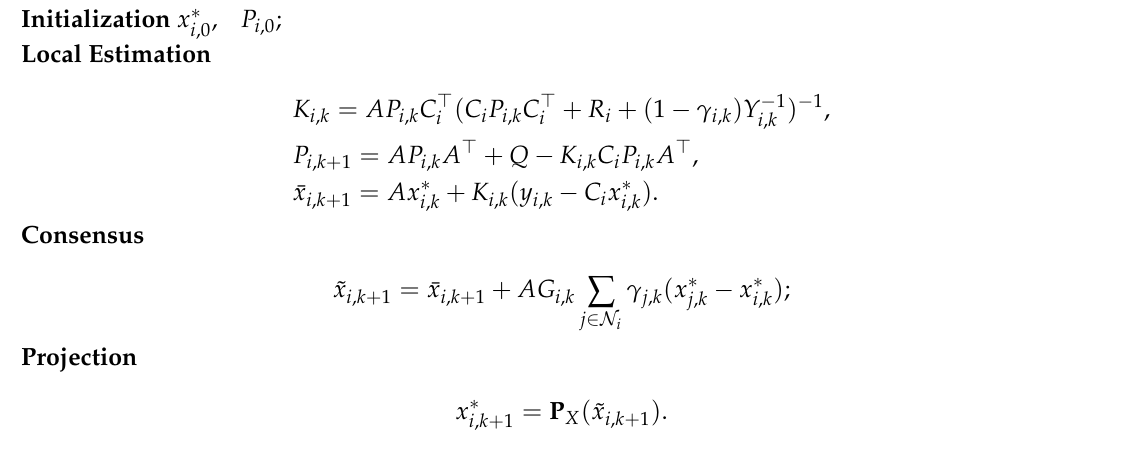
Algorithm 2 KCF with constraints via stochastic event-triggered